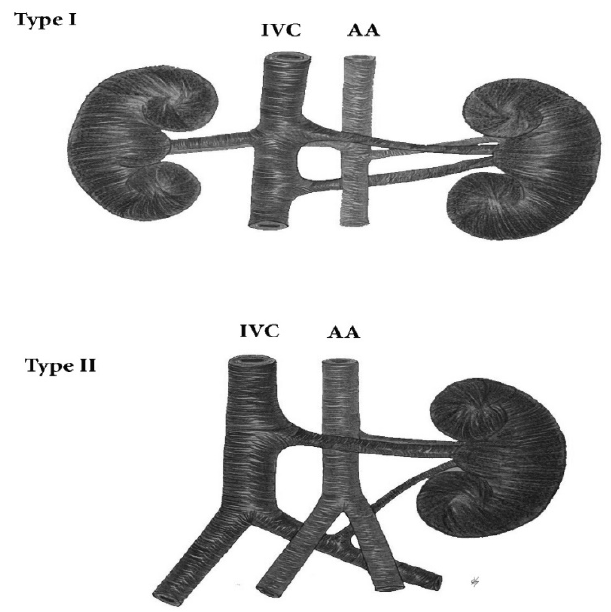
Figure 14. Circumaortic left renal vein. Type I—the additional renal vein has a retroaortic course and drains in the IVC. Type II—the additional renal vein passes behind the left common iliac artery and drains in the left common iliac vein. IVC—inferior vena cava, AA—abdominal aorta.